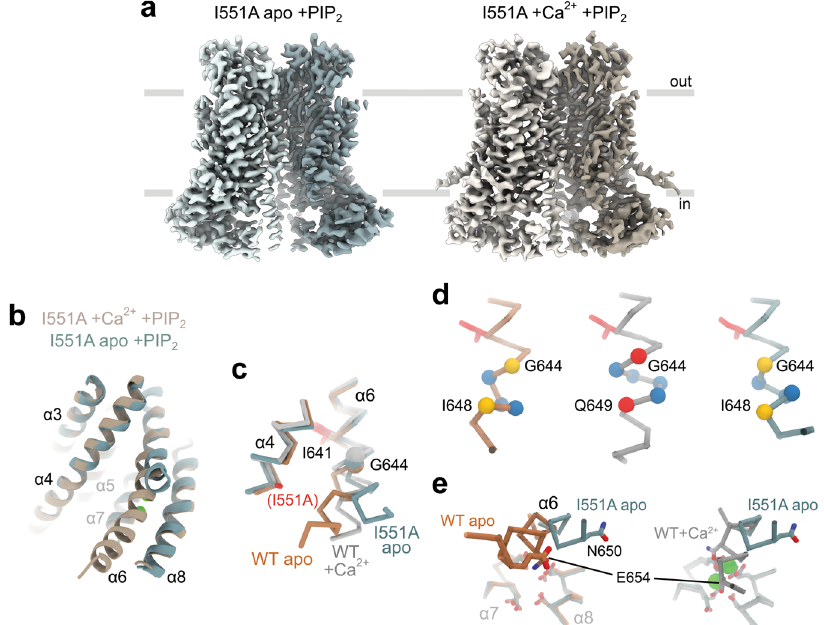
Fig. 3 Structural features of a constitutively active mutant. a Cryo-EM map of mouse TMEM16A-I551A in the absence (left) and presence (right) of 1 mM Ca 2 + supplemented with 1.5 mM diC8-PI(4,5)P 2 in GDN at 3.3 and 4.1 Å respectively. The view is from within the membrane, with the extracellular side at the top. b Superposition of the pore region ( α 3 – α 8) of the apo and Ca 2 + -bound mutant structures in ribbon representation. The view is rotated by ~45° around the dimer axis compared to a . c Superposition of α 4 and α 6 of the indicated structures in C α representation. The C α of Gly 644 is shown as sphere, the sidechains of Ile 641 and the mutation I551A in the mutant structure as sticks. The apo and Ca 2 + -bound structures of WT were previously reported 12 (PDB: 5OYG and 5OYB respectively). d Section of α 6 around Gly 644. Yellow spheres depict respective pairs of hydrogen-bonded positions in α -helix conformation, red spheres depict a pair of interacting residues in π -helix conformation, and blue spheres indicate the C α positions in between. e Superposition of the Ca 2 + binding sites of indicated structures viewed from within the membrane. The protein is shown in C α representation, and sidechains of Ca 2 + binding residues as sticks. d , e The coloring of the C α -traces is as in c . b , e Ca 2 + ions in the Ca 2 + -bound structure are shown as green